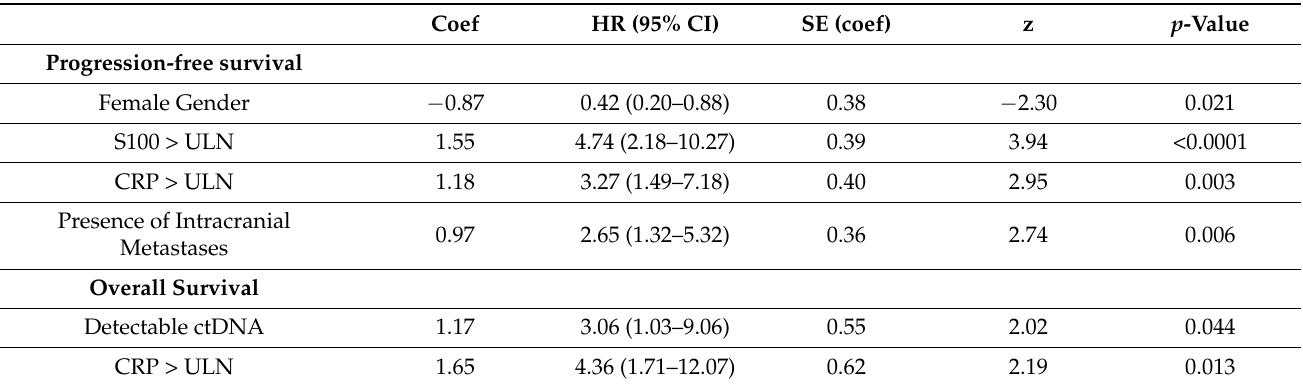
Table 2. Multivariate Cox model for progression-free and overall survival, including ctDNA detection, routine blood markers 1 , and clinical factors 2